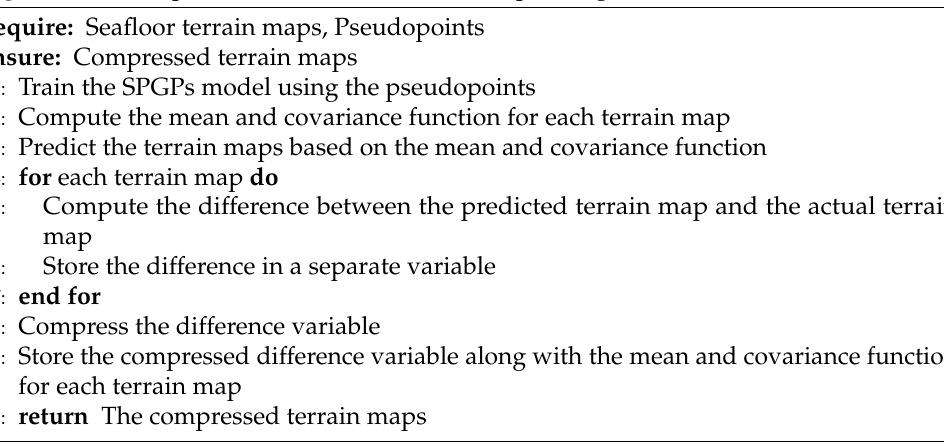
Algorithm 1 Compression of Seafloor Terrain Maps using